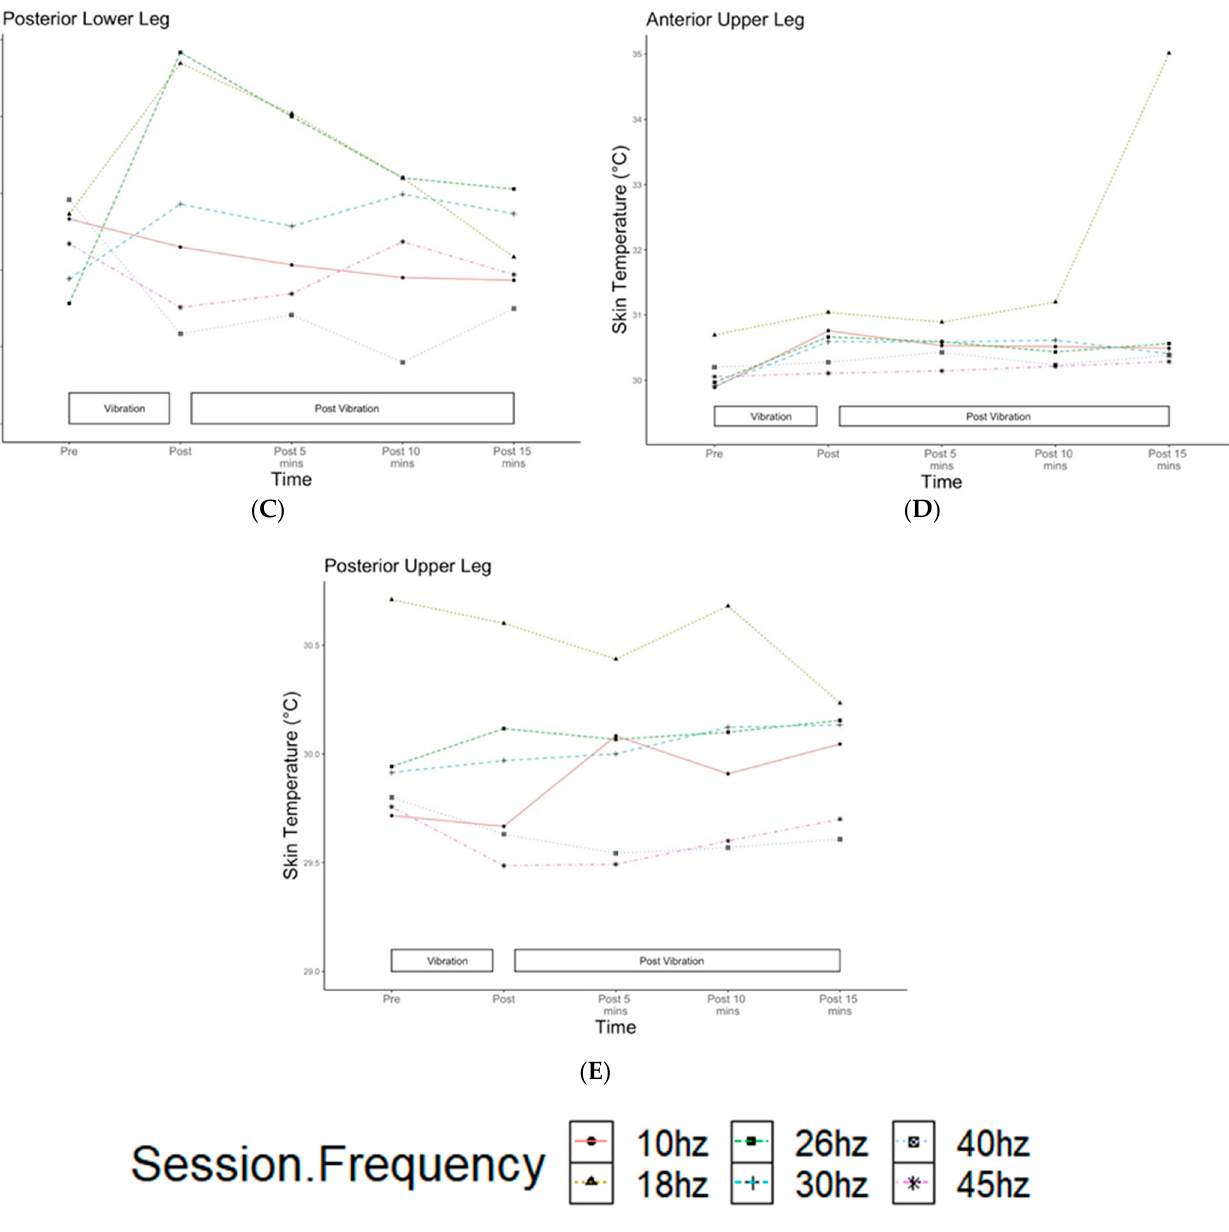
Figure 3. Changes in skin temperature. Degrees Celsius (°C) . ( A ). Foot, ( B ). Anterior lower leg, ( C ). Posterior lower leg, ( D ). Anterior upper leg, ( E ). Posterior uppper leg.